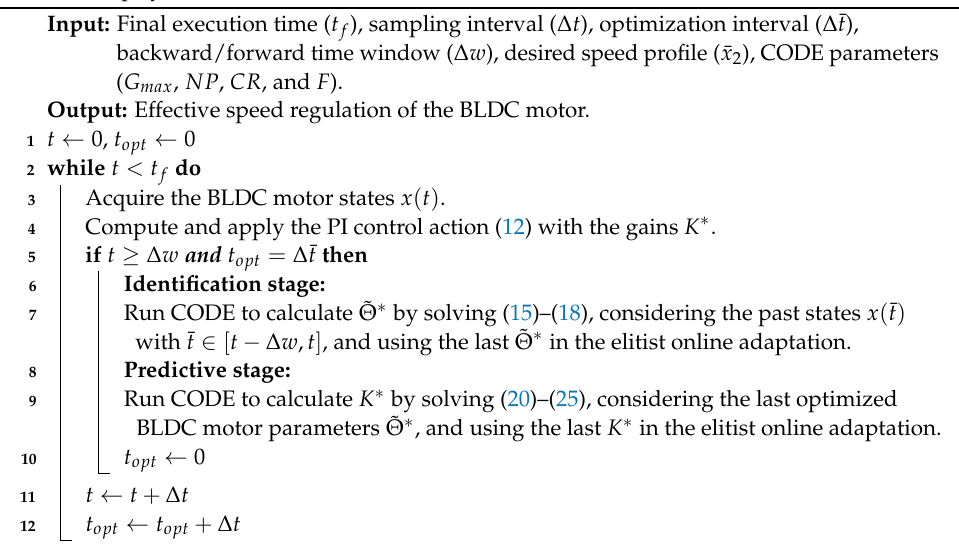
Algorithm 2: Chaotic adaptive tuning strategy for controller gains (CATSCG) in the closed-loop system of a BLDC